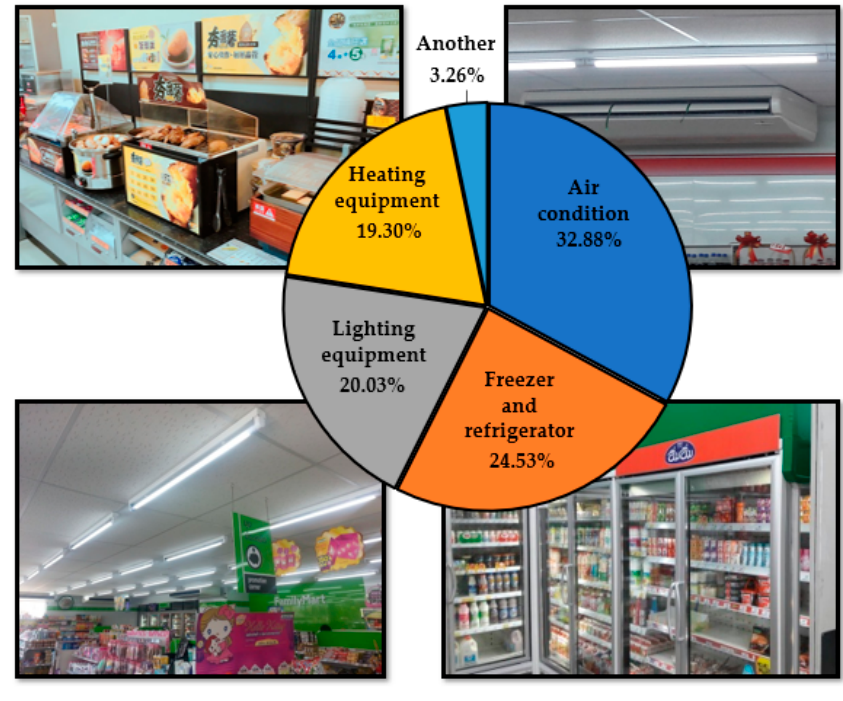
Figure 1. Proportions of energy use in Taiwanese convenience stores [5].